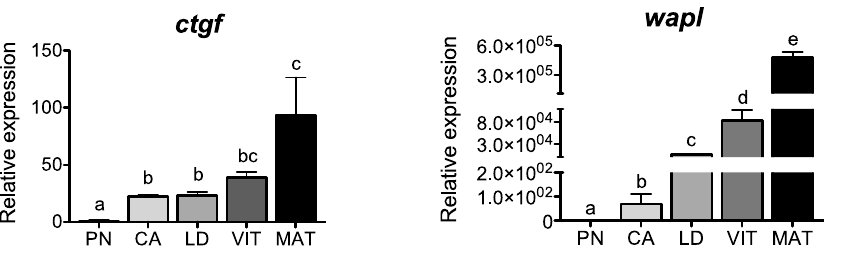
Fig. 5. Expression profiles of genes associated with tissue or extracellular matrix remodeling during major stages of oogenesis in coho salmon. Messenger RNA levels were analyzed by qPCR and data were normalized to the geometric mean of four reference genes ( eef1a , ctsd , ctsz and actb ). PN, perinucleolus stage follicles; CA, cortical alveolus stage follicles; LD, lipid droplet stage follicles; VIT, mid-vitellogenic stage follicles; MAT, postvitellogenic/preovulatory stage follicles. Bars not sharing the same letter are significantly different (P , 0.05; n 5 4 fish/stage for PN-, CA-, LD-, and VIT-stages, n 5 3 fish for MAT-stage, mean ¡